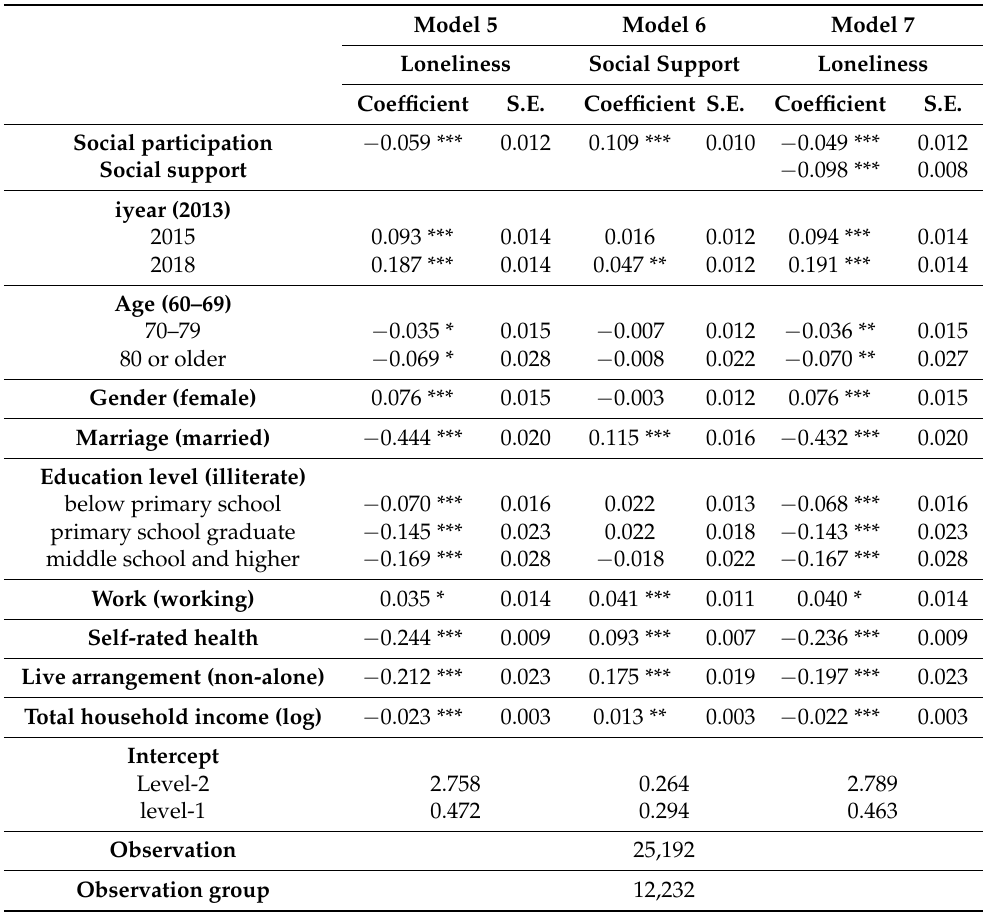
Table 5. Mediating pathway test results of the influence of social participation on